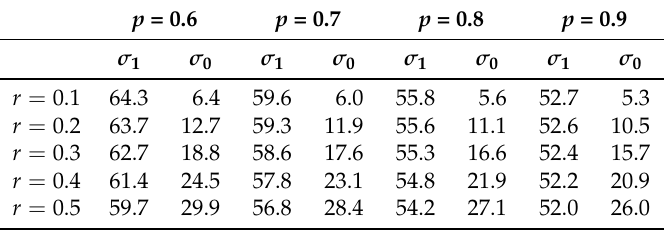
Table 1. Values of σ 1 and σ 0 (in µm) for p = 0.6,0.7,0.8,0.9 and r = 0.1,0.2,0.3,0.4,0.5. p = 0.6 p =